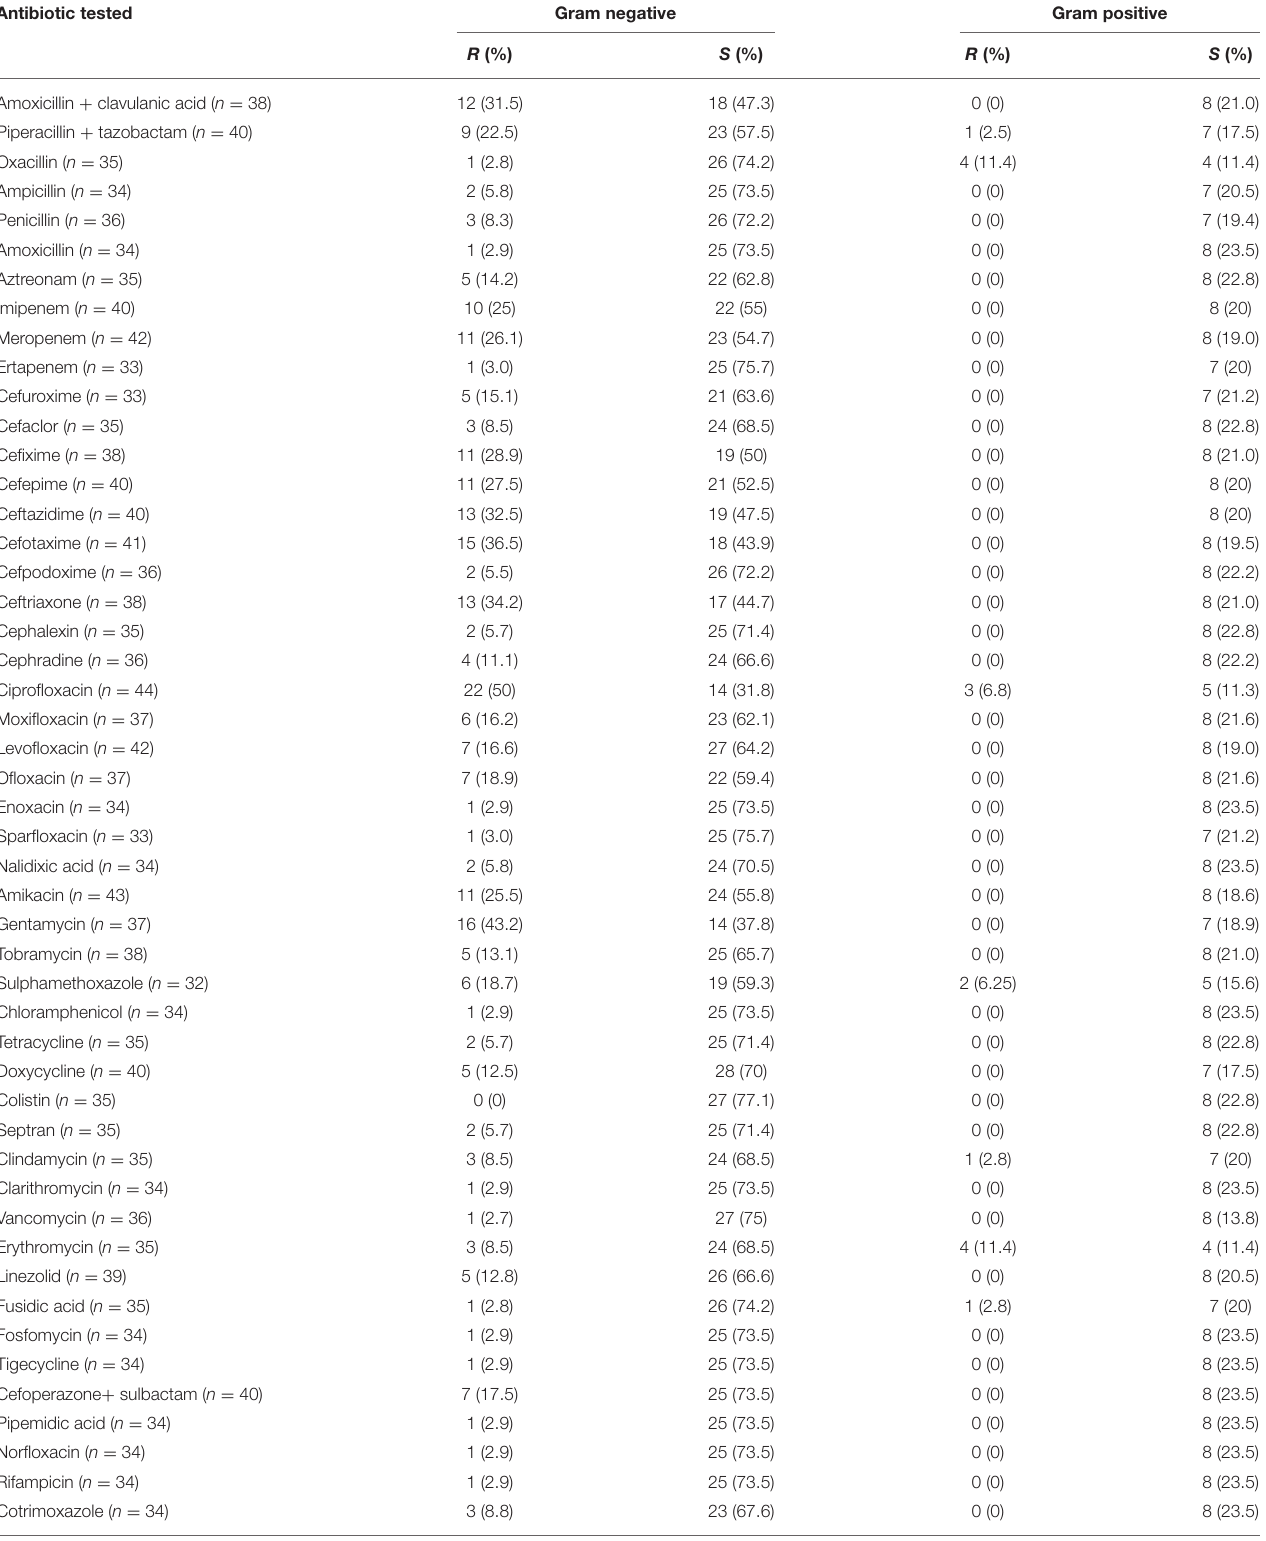
TABLE 2 | Antibiotic sensitivity and resistance against organism isolates ( N = 110). Antibiotic tested Gram